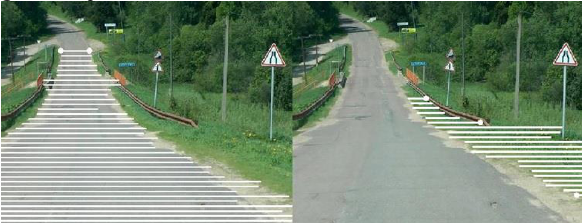
Figure 3 . Continuous germs of global